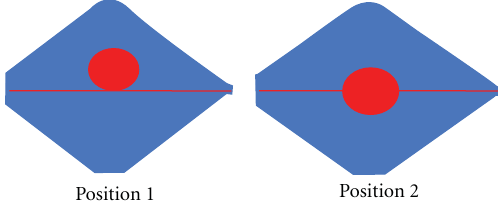
Figure 18: Two inlet positions used in the